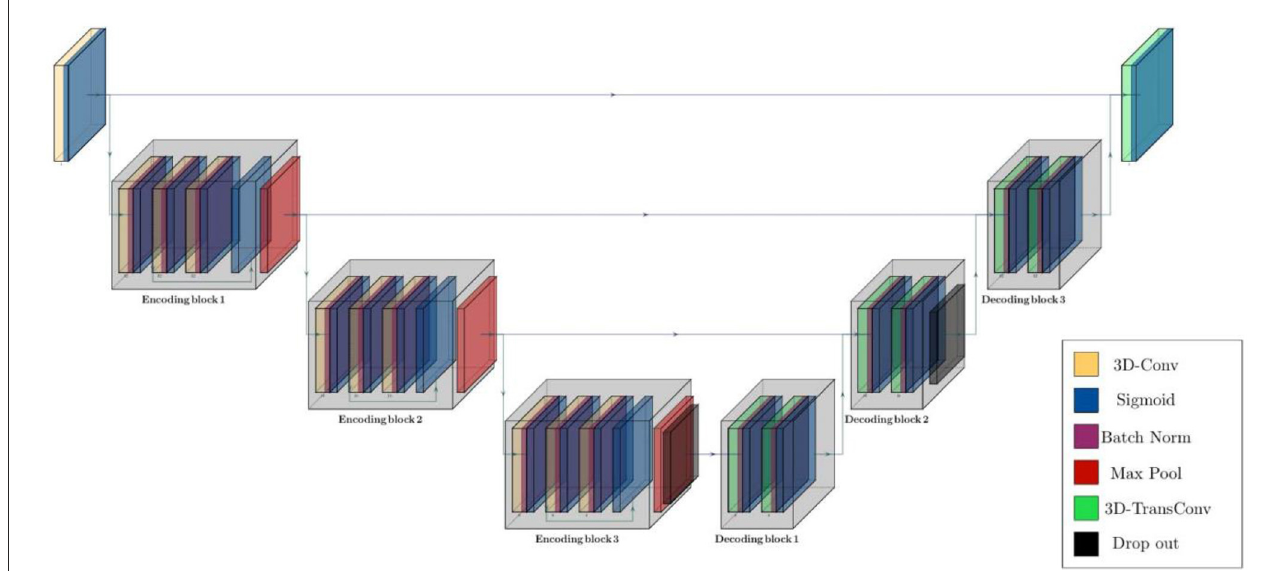
FIGURE2 Schematic diagram of residual parcellation model with U-Net style structure including encoding and decoding blocks that contain combination of layers such as 3D convolution, max pooling, batch normalization, drop out, and convolution transposed. Black arrows show skip connections and data flow in and outside of each block.